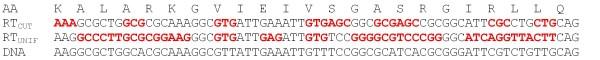
Comparison between reverse translation of the Escherichia coli K-12 MG1655 LexA protein (NP_418467) assuming a uniform codon distribution (RTUNIF) and using the E. coli codon usage table (RTCUT) supplied by the Codon Usage Database [[16]]. Red bold indicates deviation from the real DNA sequence shown at the bottom.